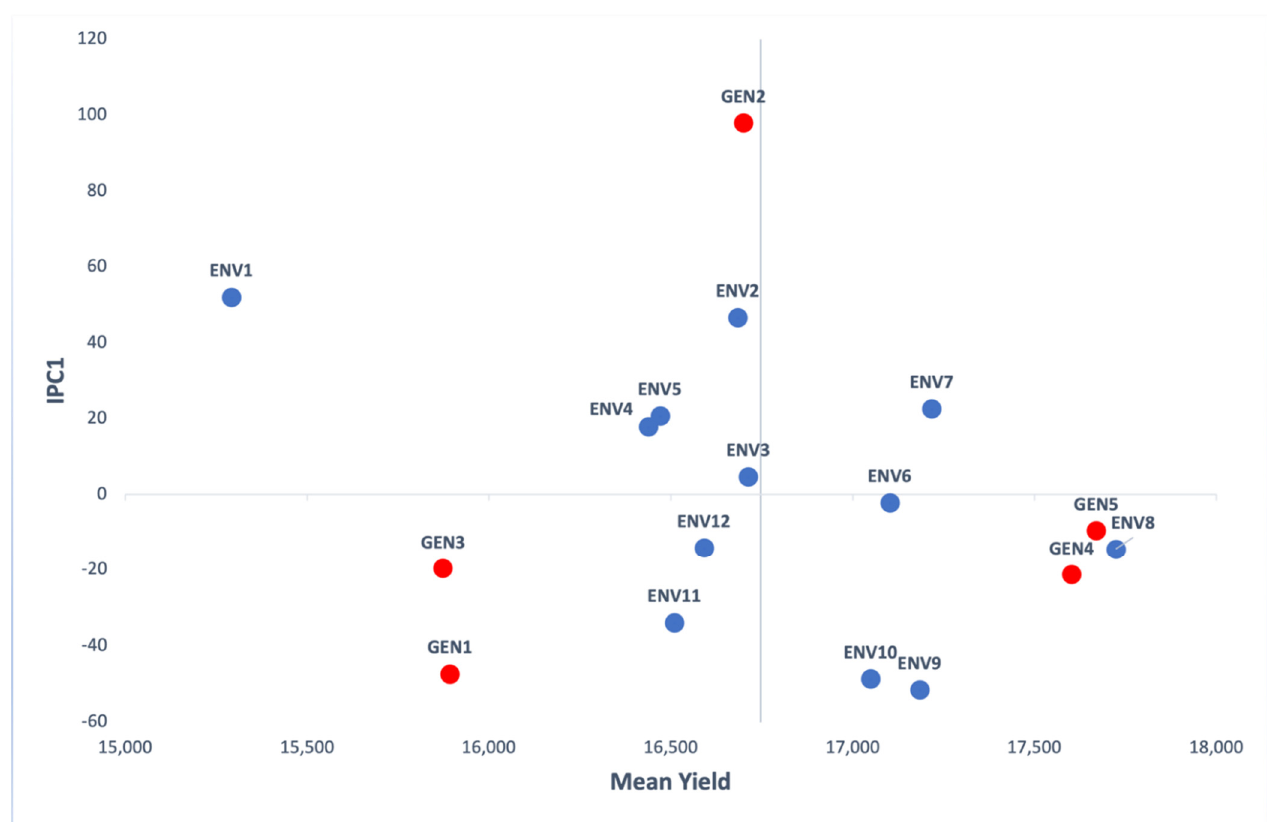
Figure 1. AMMI biplot presenting mean grain yield (kg/ha) and the first interaction principal component (IPC1) of five genotypes evaluated in 12 environments.